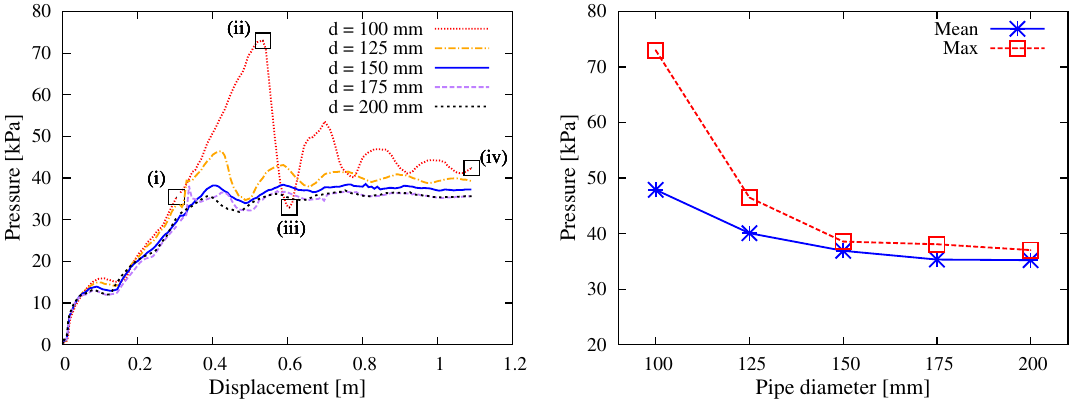
Figure 10. Simulation results with respect to the pipe diameter: ( left ) curves of the thrusting pressure vs. displacement relationship; and ( right ) mean and max values during the stable pumping stage.